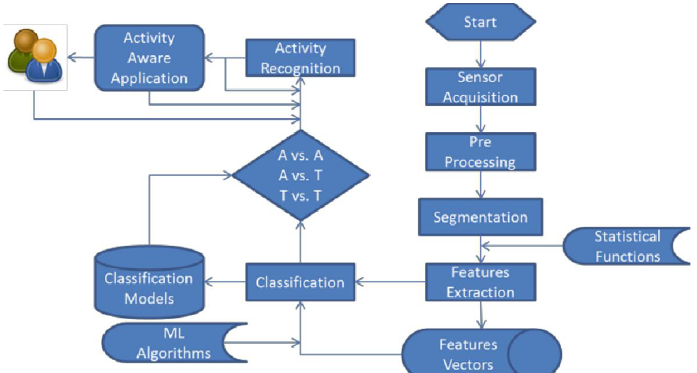
FIG. 2. OVERALL EXECUTION FLOW OF AN ADPATIVE HAR